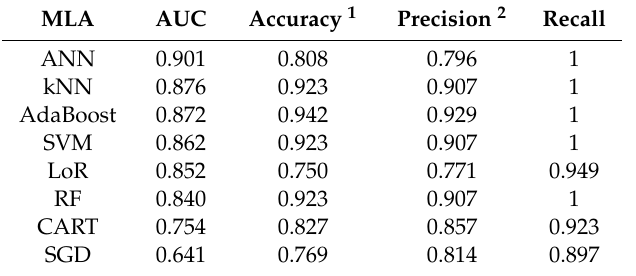
Table 5. MLA classification evaluation for the extrusion ‐ blow molding process.